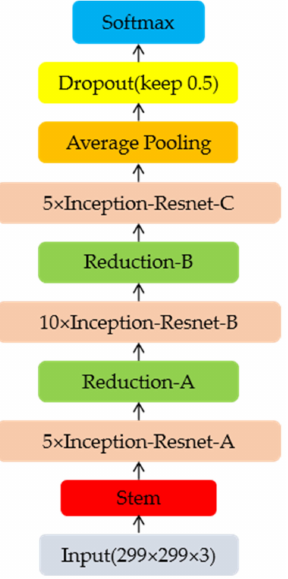
Figure 7. The architecture of Inception-ResnetV2.